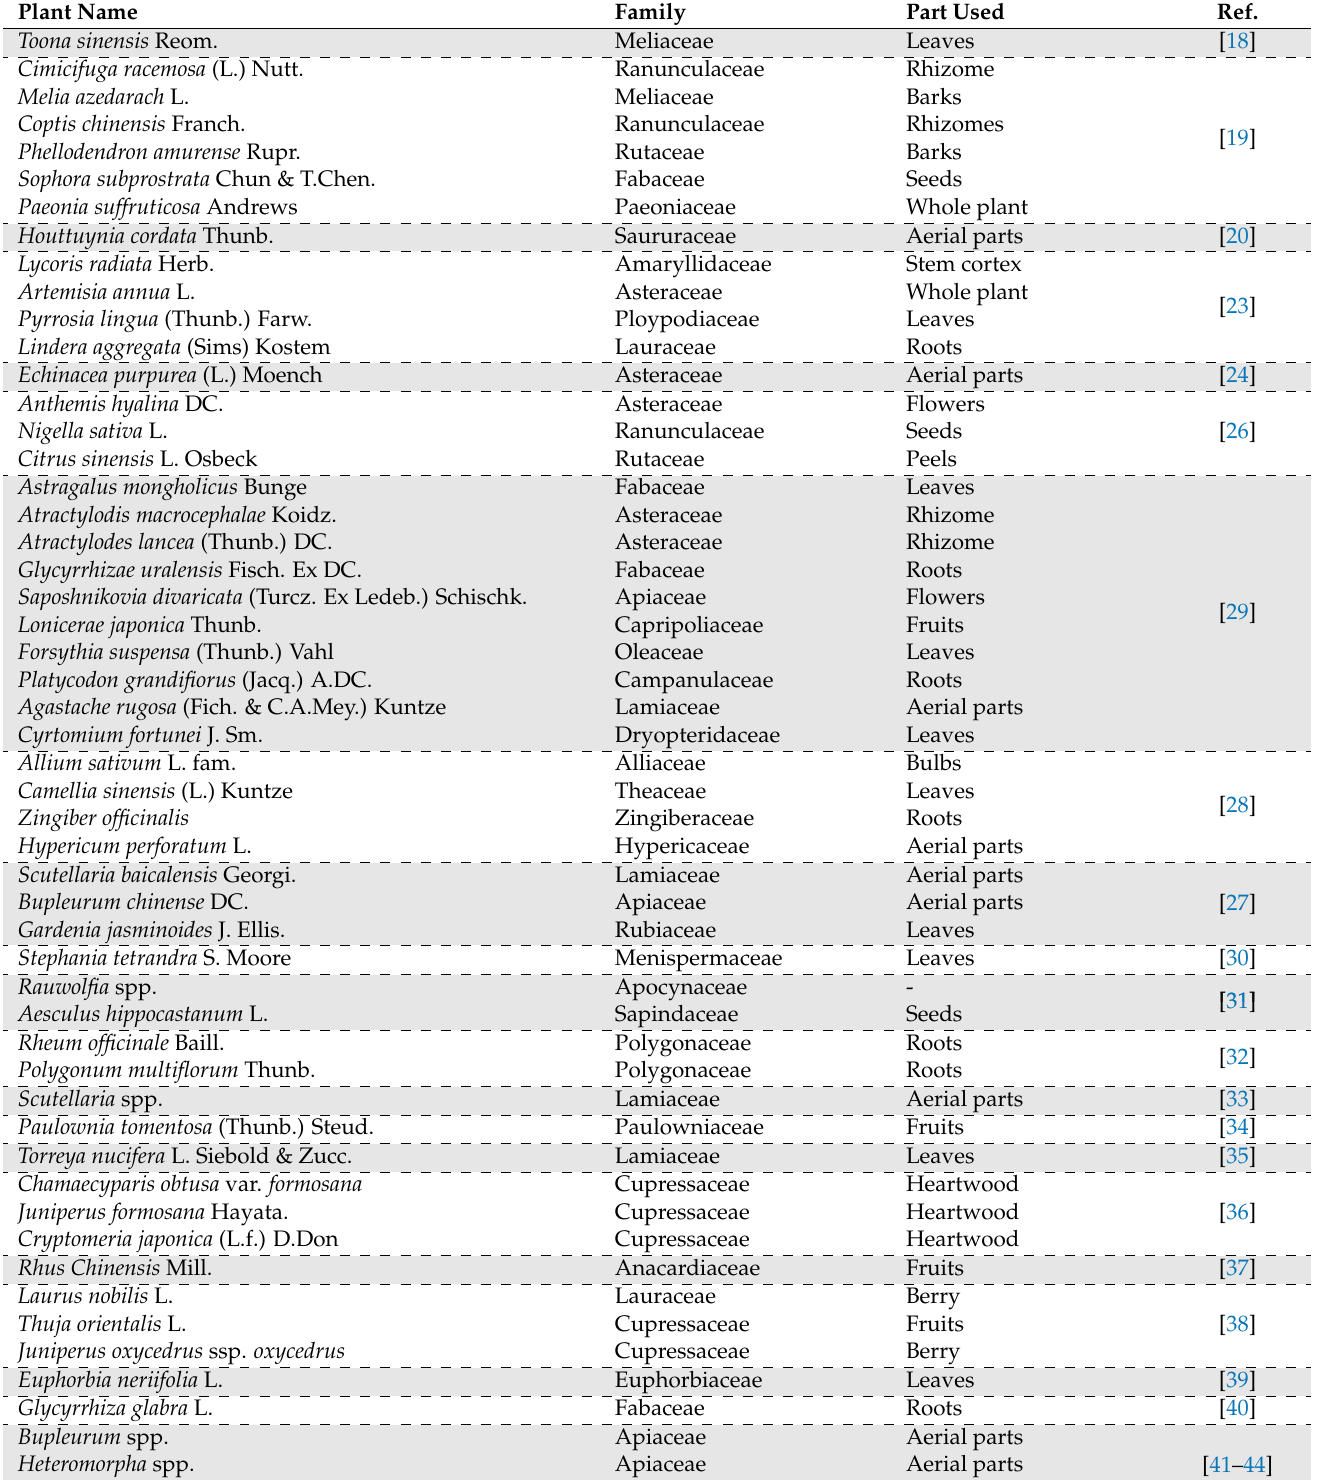
Table 1. Anti-Human Coronavirus (anti-HCoV) activities of some medicinal